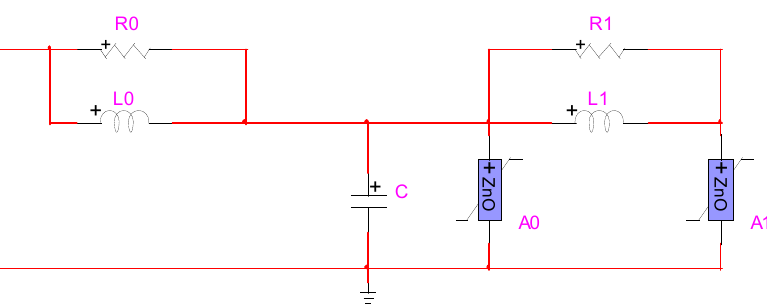
Figure 3. Frequency-dependent metal oxide surge arrester [42].